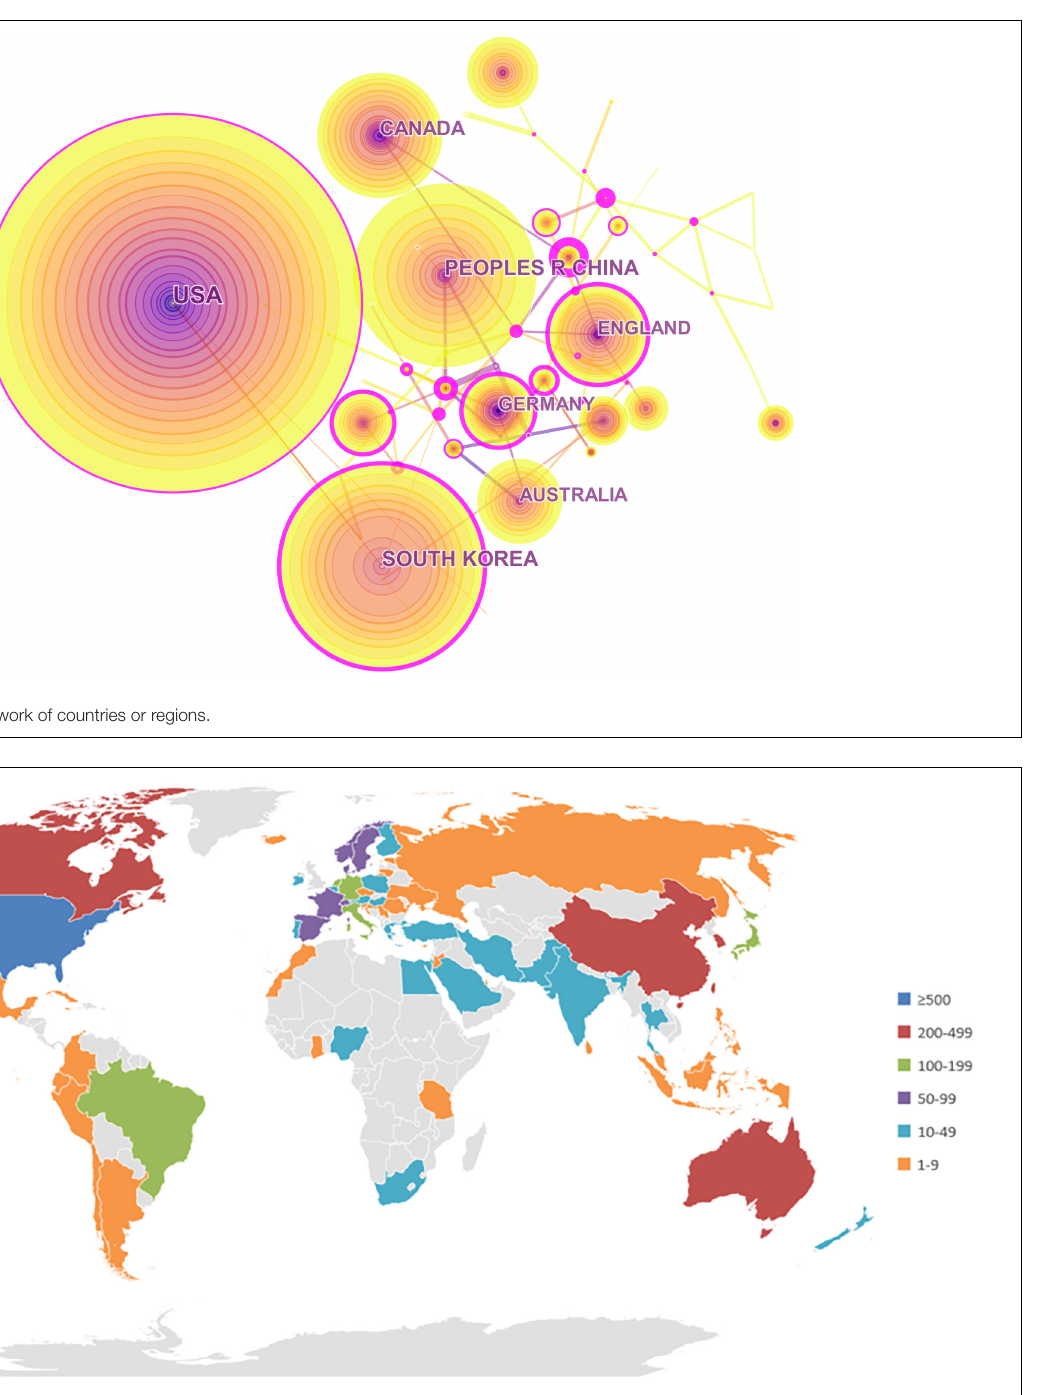
FIGURE 3 | World map of the total output of countries or